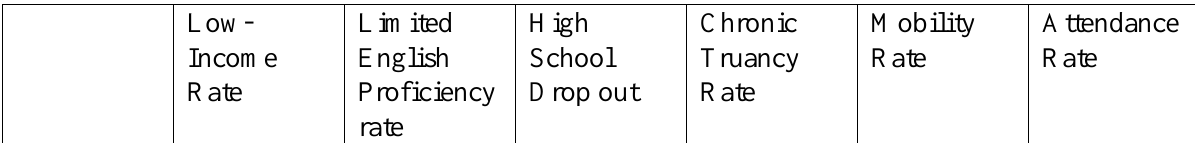
School Characteristics and Percentages of Students for the High